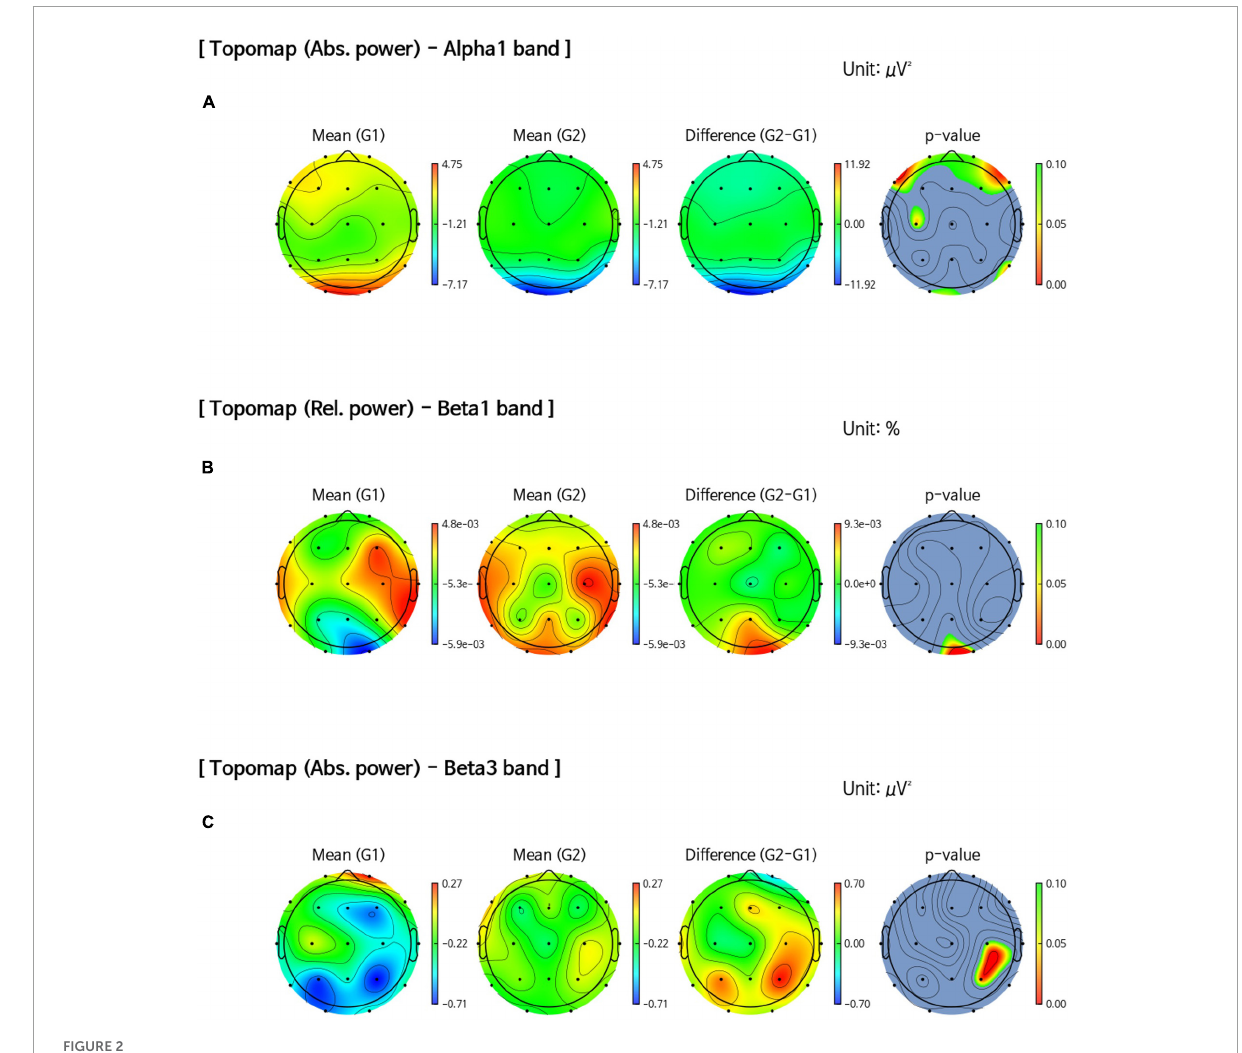
the characteristic path length of alpha1 band was decreased in the right supramarginal gyrus ( p = 0.003) and right rostral middle frontal cortex ( p = 0.003) in all intervention groups after multiple imputation for missing data ( Table 3